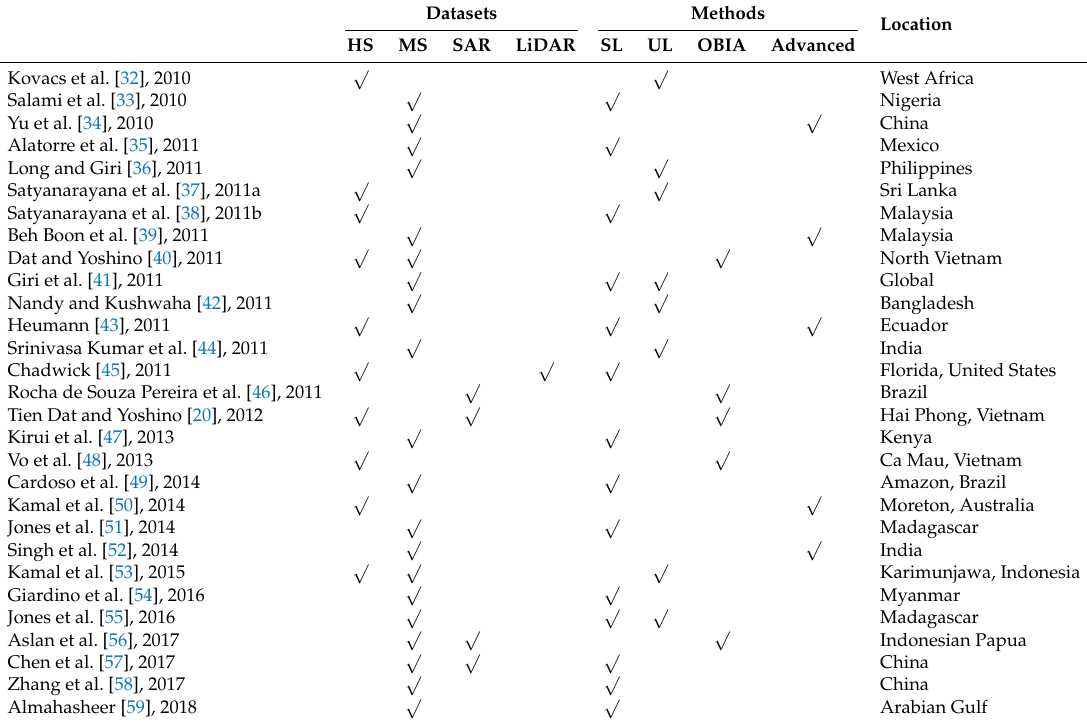
Table 2. Remote sensing techniques for mapping mangroves using remotely-sensed data from 2010–2018. OBIA, object-based image